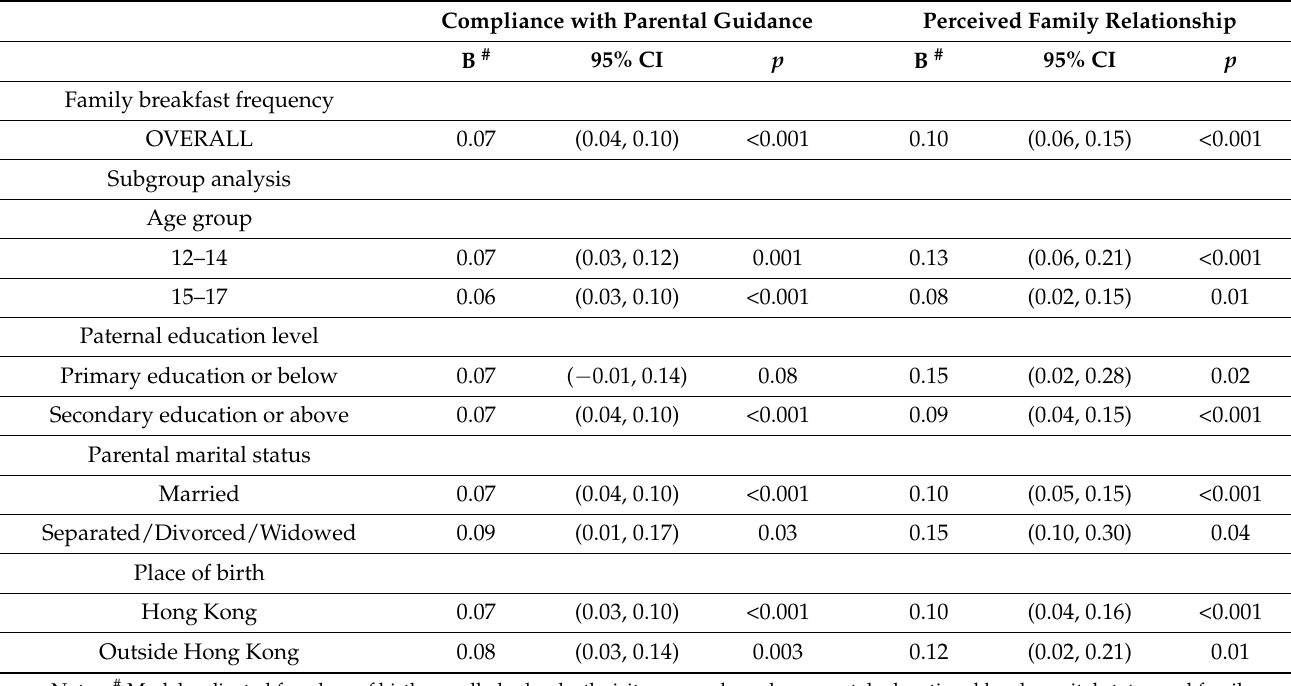
Table 3. Linear regression analyses of the association between family breakfast frequency and adolescent perception of family relationship and compliance with parental